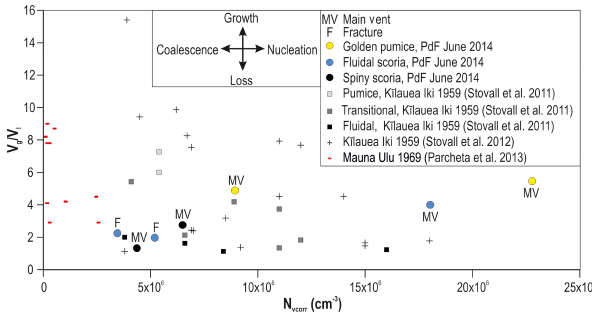
Figure 11. Volumetric ratio of vesicles to melt ( V g /V l ) versus vesi- cle number